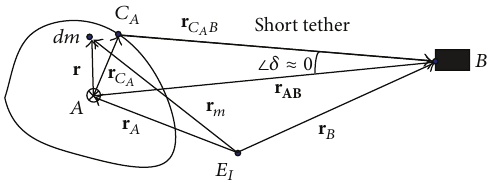
Figure 3: The detailed configuration of the ROGER spacecraft.